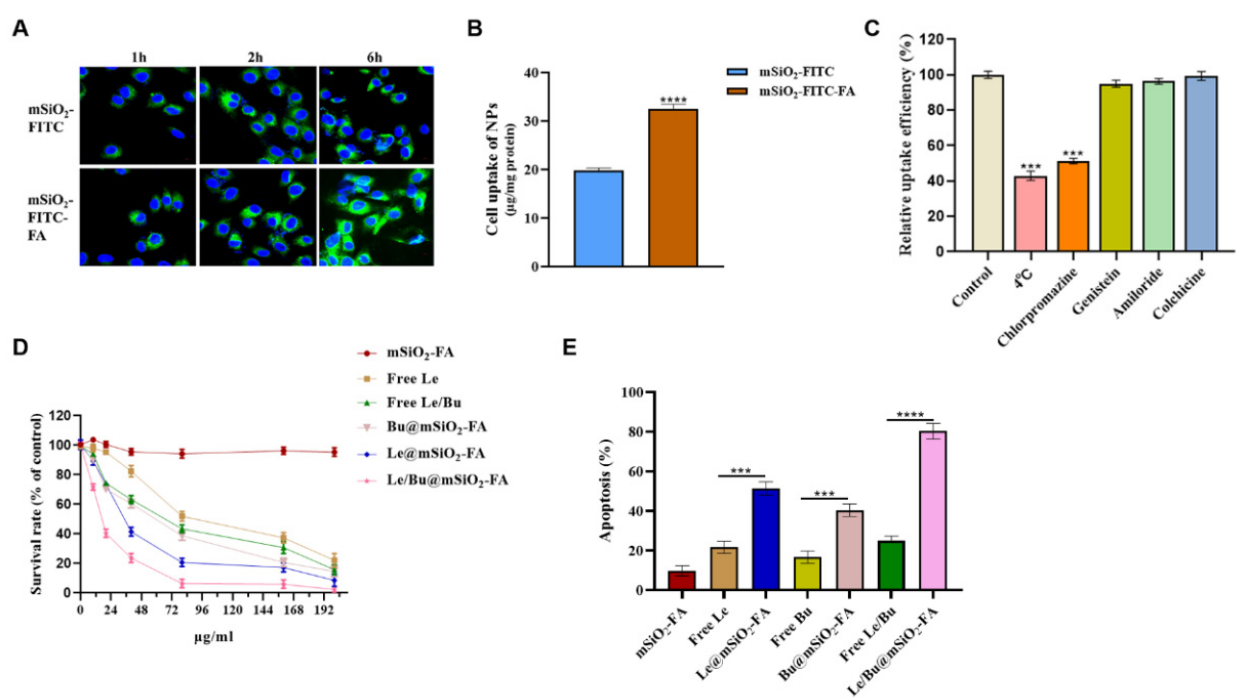
Figure 4. ( A ) Confocal laser scanning microscopy (CLSM) images of the 9810 tumor cells incubated with the same concentration (100 mg/mL) of mSiO 2 and mSiO 2 -FA for 1, 2, and 6 h. Blue indicates DAPI nuclear stain, green is FITC fluorescence. ( B ) Uptake of mSiO 2 and mSiO 2 -FA nanoparticles in 9810 cells at 6 h. ( C ) Relative uptake efficiency of mSiO 2 -FA nanoparticles in 9810 cells in the presence of various endocytosis inhibitors. ( D ) In vitro cytotoxicity of mSiO 2 -FA, free Le, free drugs